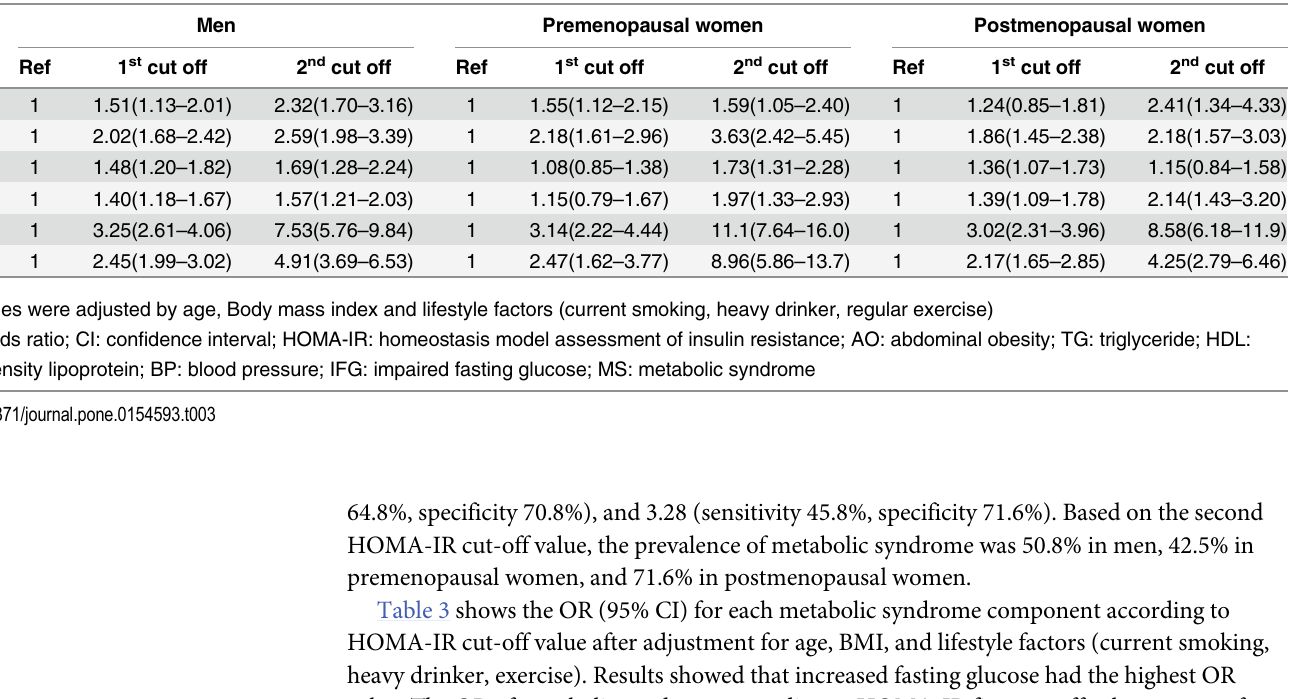
Table 3. Multivariate OR (95% CI) of metabolic syndrome component according to HOMA-IR cut off